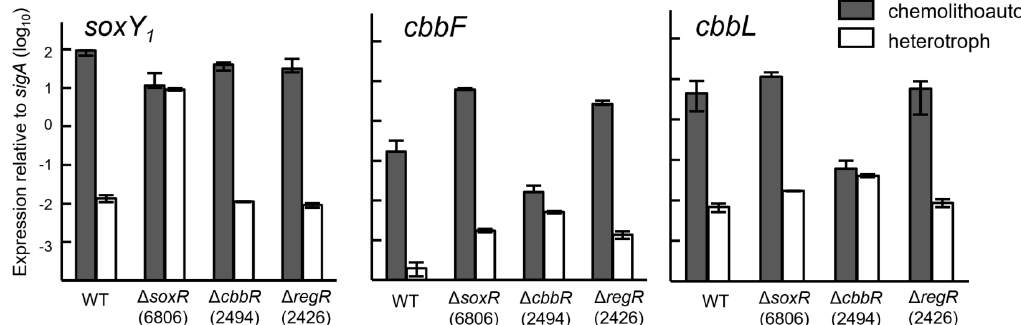
Figure 5. Expression of the soxY 1 , cbbF , and cbbL genes in the B. diazoefficiens wild type (WT) and in regulatory mutants ∆ soxR (6806), ∆ cbbR (2494) and ∆ regR (2426). Expression was measured by qRT-PCR in cells grown heterotrophically (with 4 mM succinate) and chemolithoautotrophically (with 4 mM thiosulfate). The expression of each gene under each condition had been normalized to that of the housekeeping sigma factor gene sigA . The column heights and error bars represent the means and standard deviations for three cultures where each culture was measured in triplicate.